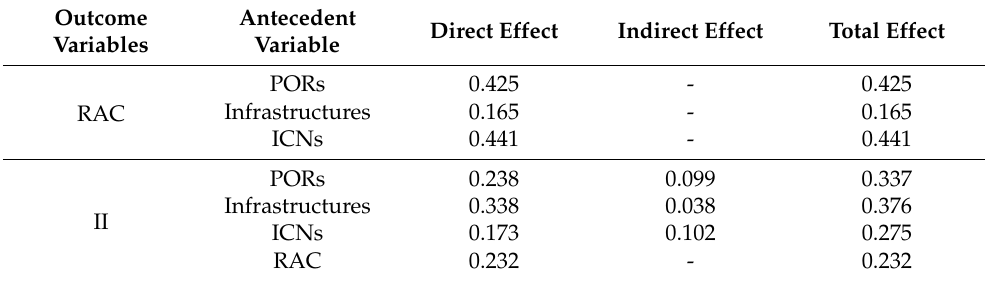
Table 6. Effect size of